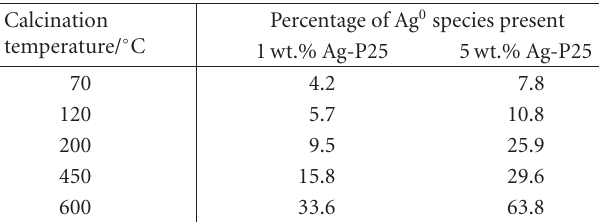
Table 4: XPS data showing ratio of silver species for 1 wt.% Ag- TiO 2 and 5wt.% Ag-TiO 2 photocatalysts at various calcination tem-